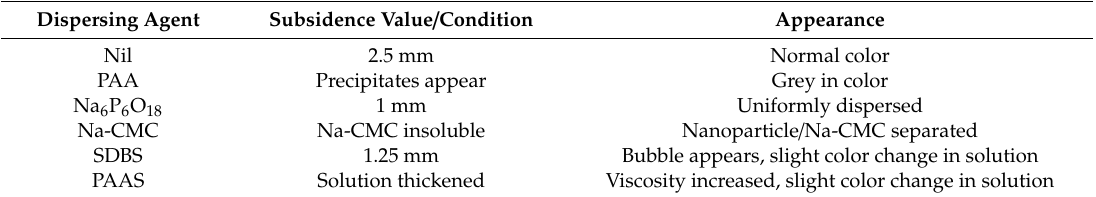
Table 1. The subsidence condition and final appearance of Ag-HZDP in melamine resin solution using five dispersing agents .